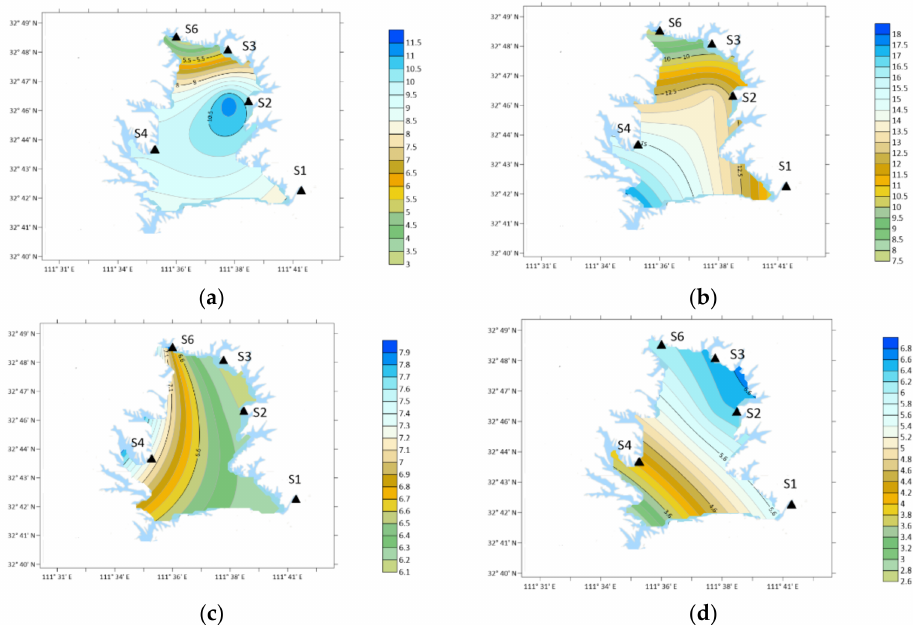
Figure 11. Spatial variation of DBA concentration. ( a ) Winter; ( b ) spring; ( c ) summer; ( d ) autumn.